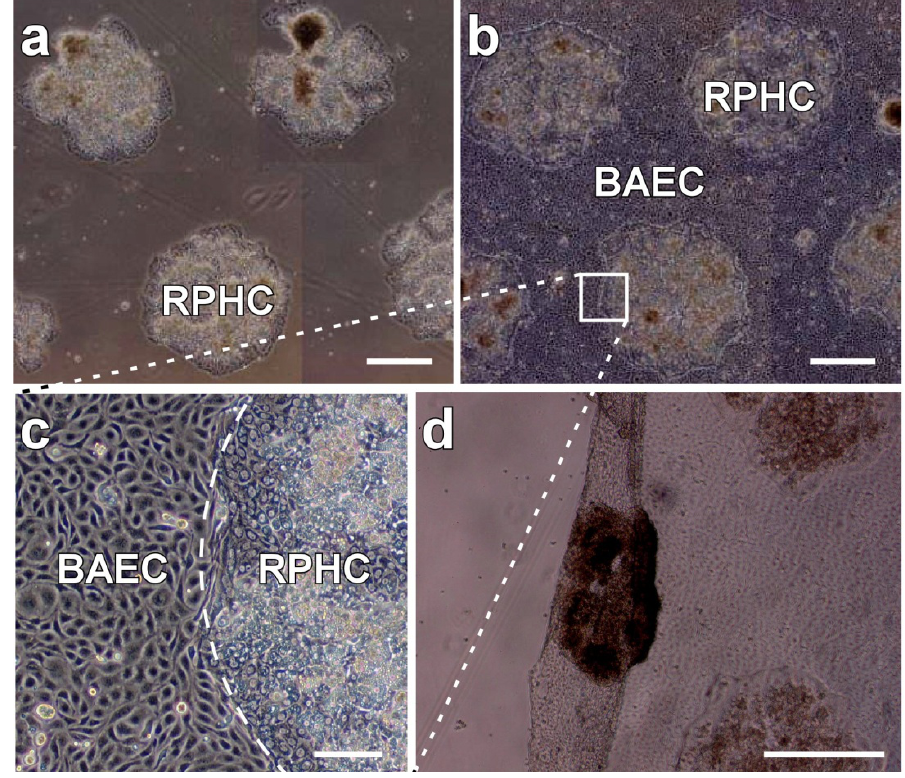
Figure 9. Patterned dual temperature-responsive surface for the co-culture of rat primary hepatocytes (RPHCs) and bovine aortic endothelial cells (BAECs). ( a ) RPHCs have adhered and proliferated on poly( N -isopropylacrylamide- n -butyl methacrylate) (P(IPAAm-BMA)) co-grafted domain at 27 °C; ( b ) BAECs have adhered and proliferated on PIPAAm-grafted domain at 37 °C and been co-cultured with RPHCs; ( c ) the magnified view of the periphery of patterned co-cultures (the black square region in ( b )); ( d ) a co-cultured cell sheet is detaching itself from the patterned culture surface. Scale bars: ( a ), ( b ), and ( d ): 0.5 mm and ( c ): 0.2